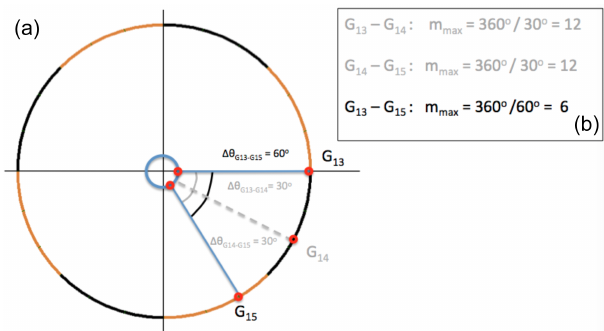
Figure 1. Relative azimuthal locations of three GOES satellites on October, 2012 (a) , and maximum m numbers that can be calculated by spacecraft pairs (b)